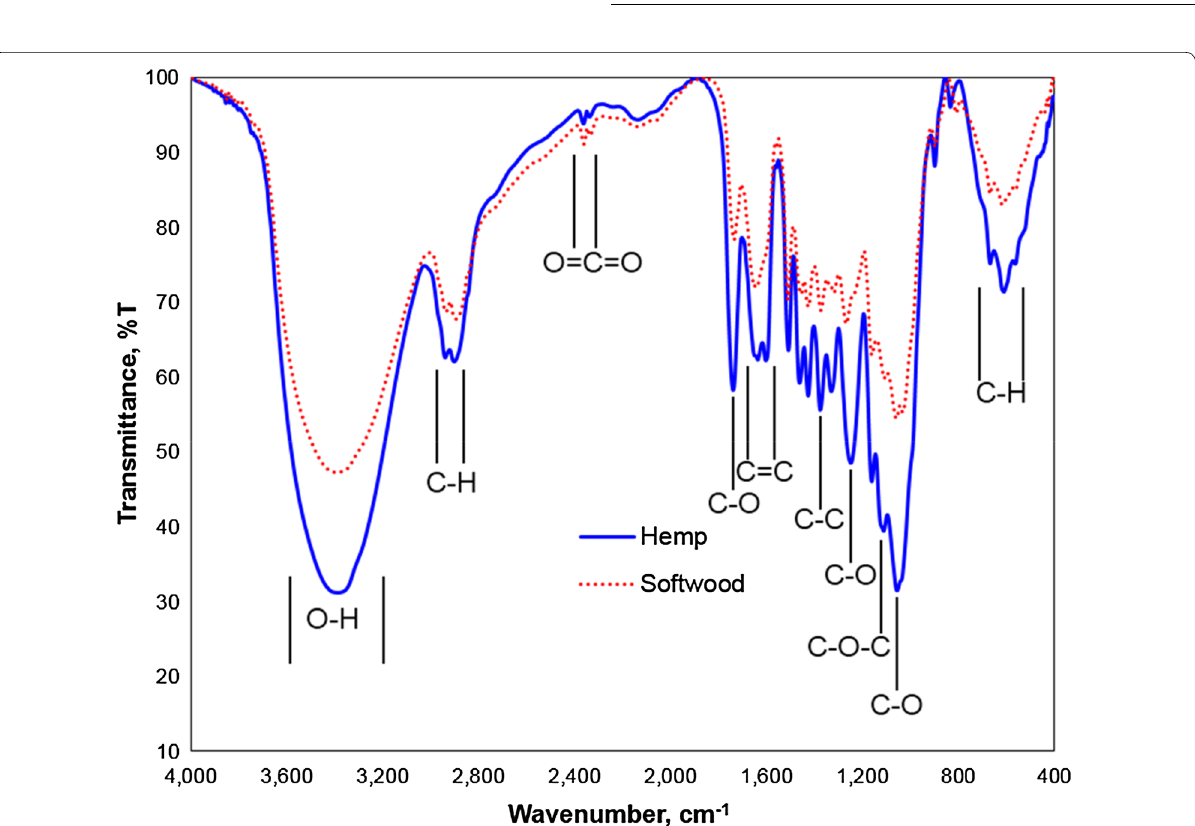
Fig. 4 FT-IR spectra of raw softwood and hemp feedstocks